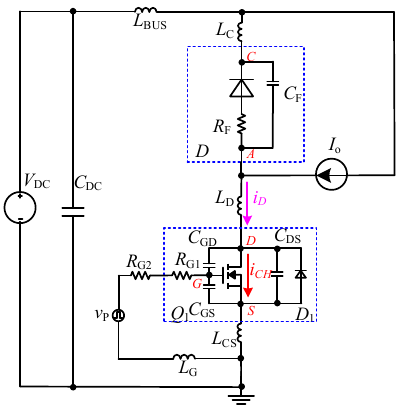
Figure 1. Double-pulse circuit considering the parasitic elements.